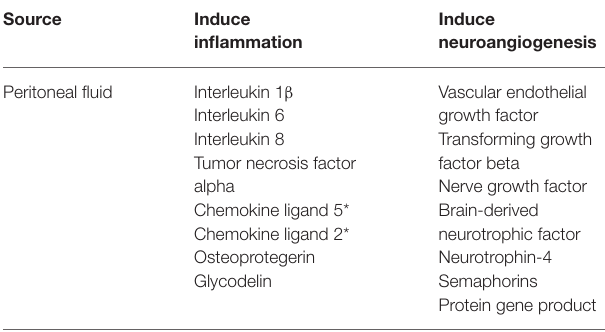
TABLE 1 | Local mediators of inflammation and neuroangiogenesis in